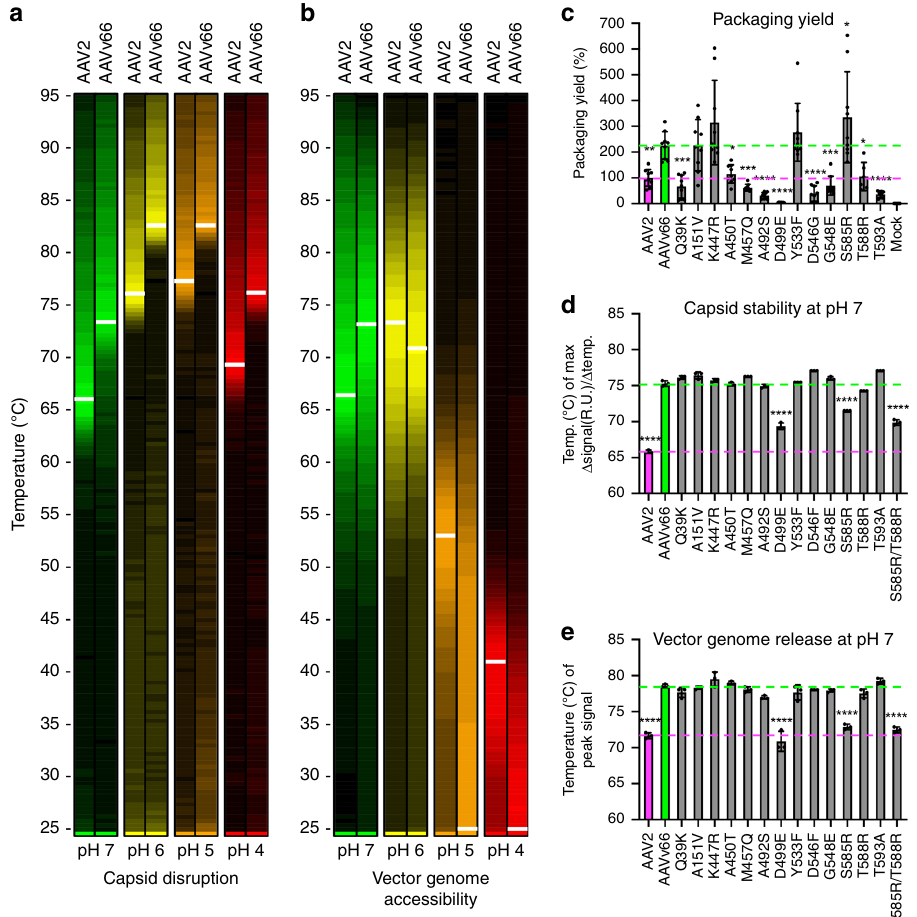
Fig. 4 Biophysical analyses of AAVv66. a , b Heatmap displays of differential scanning fl uorimetry (DSF) analyses to query ( a ) capsid protein unfolding (uncoating) and ( b ) DNA accessibility (vector genome extrusion) at pHs 7, 6, 5, and 4. Color scaling depicted represent relative peak signals from highest to lowest value (brightest to dimmest, respectively). c – e Each de fi ning amino acid residue of AAVv66 was converted to those of AAV2 by site-directed mutagenesis and examined for changes in c packaging yield, d capsid stability, and e genome release at pH 7. Values represent mean ± SD. p Values were determined by one-way ANOVA. * p < 0.05, ** p < 0.01, *** p < 0.001, **** p < 0.0001. n =